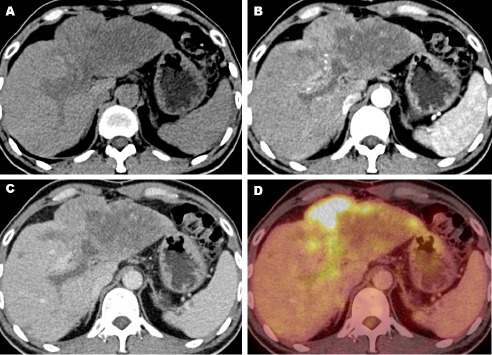
The contrast-enhanced FDG PET/CT shows a liver tumor with heterogeneous mild contrast enhancement and increased FDG uptake, adjacent to the left expansile thrombosed portal vein. The thrombus appeared hypodense in the non-enhanced CT image (A). It showed perithrombus contrast-enhancement in the arterial phase CT (B), washed out in the portal venous phase CT (C), and showed an increased FDG uptake in the PET/CT image (D)